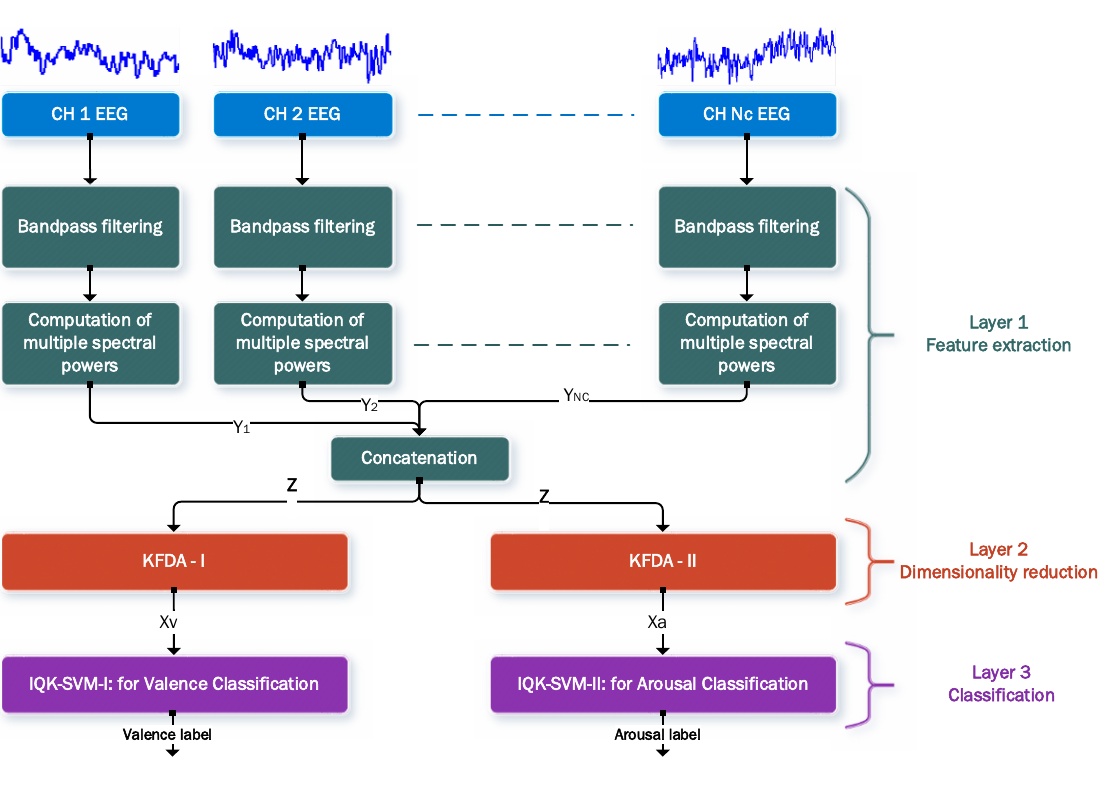
Figure 2. Proposed kernel machine-based three-layer EEG-ER scheme. In this figure, z denotes a spectral power (SP) vector, and both Xa and Xv are